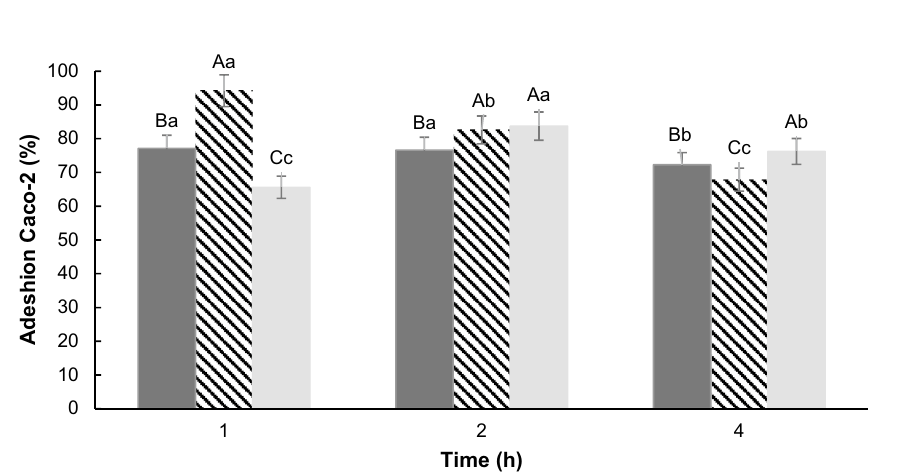
Figure 2. Adhesion (%) of L1 (filled black square), L2 ( ) and EF (filled gray square) to Caco-2 cells, after 1, 2 and 4 h of incubation. Different uppercase letters indicate statistically significant differences for all cultures taken at the same time (P < 0.005). Different lowercase letters indicate statistically significant differences for the same strain at different timepoints (P < 0.005). Bars represent means ± standard deviation, n =